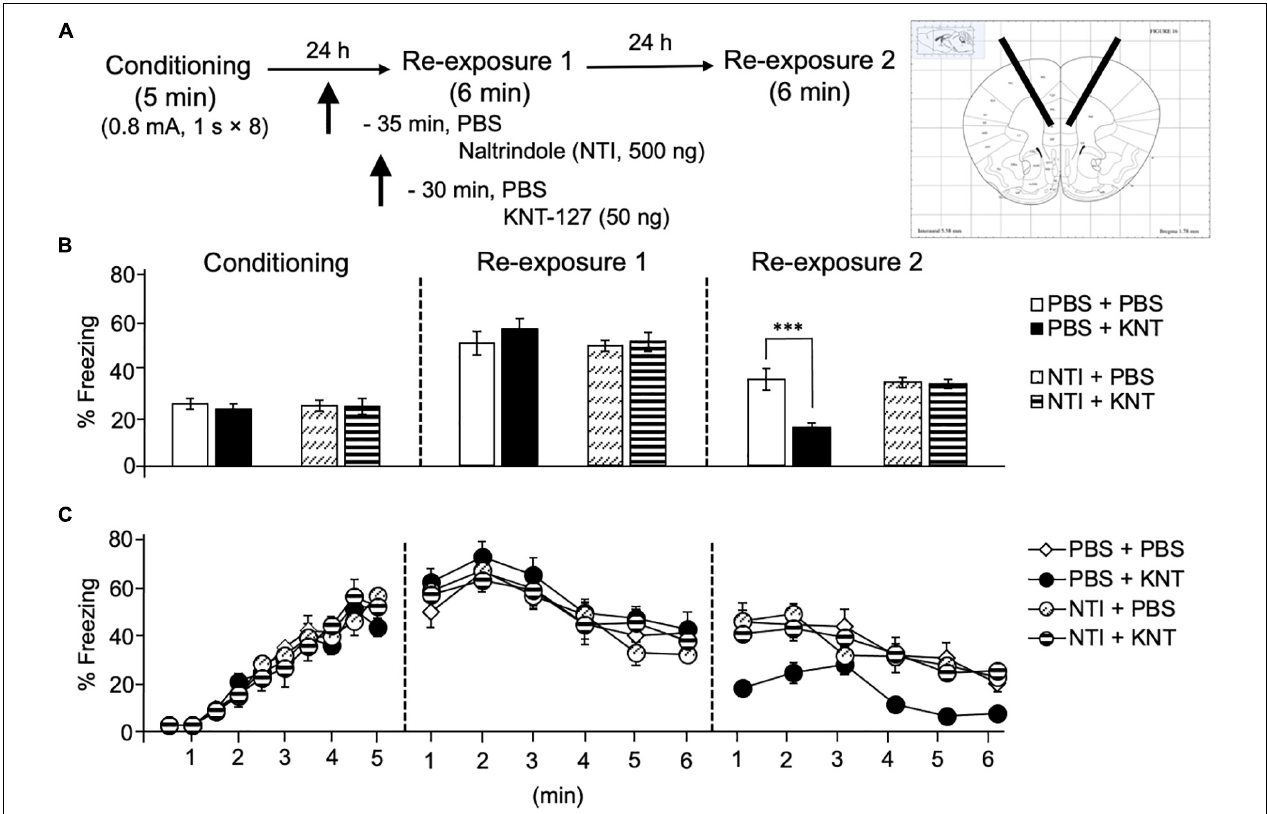
FIGURE 4 | Intra-IL administration of KNT-127 significantly and DOP-dependently reduced the contextual fear memory only in reexposure 2. (A) Experimental design. Mice were bilaterally administered with PBS or KNT-127 (50 ng) into the IL 30 min before reexposure 1 (6 min). Five minutes before injecting these drugs, DOP antagonist naltrindole (NTI) was administered similarly (35 min before reexposure 1). Twenty-four hours after reexposure 1, a fear memory was tested in the same context for 6 min (reexposure 2). (B) Freezing rates of mice during conditioning, reexposures 1 and 2. NTI abolished the effects of KNT-127 during reexposures 2. The number of mice in each group was as follows: n = 6 for PBS and subsequent PBS (PBS + PBS), n = 7 for PBS and subsequent KNT-127 (PBS + KNT), n = 8 for NTI and subsequent PBS (NTI + PBS), and n = 9 for NTI and subsequent KNT-127 (NTI + KNT). (C) Time course of the freezing rates of mice during conditioning, reexposures 1 and 2. Data are expressed as the means ± SEM. Data were expressed as mean ± SEM. ∗∗∗ p < 0.001 for comparisons between KNT and NTI treatment groups by one-way or two-way ANOVA and post hoc Bonferroni’s